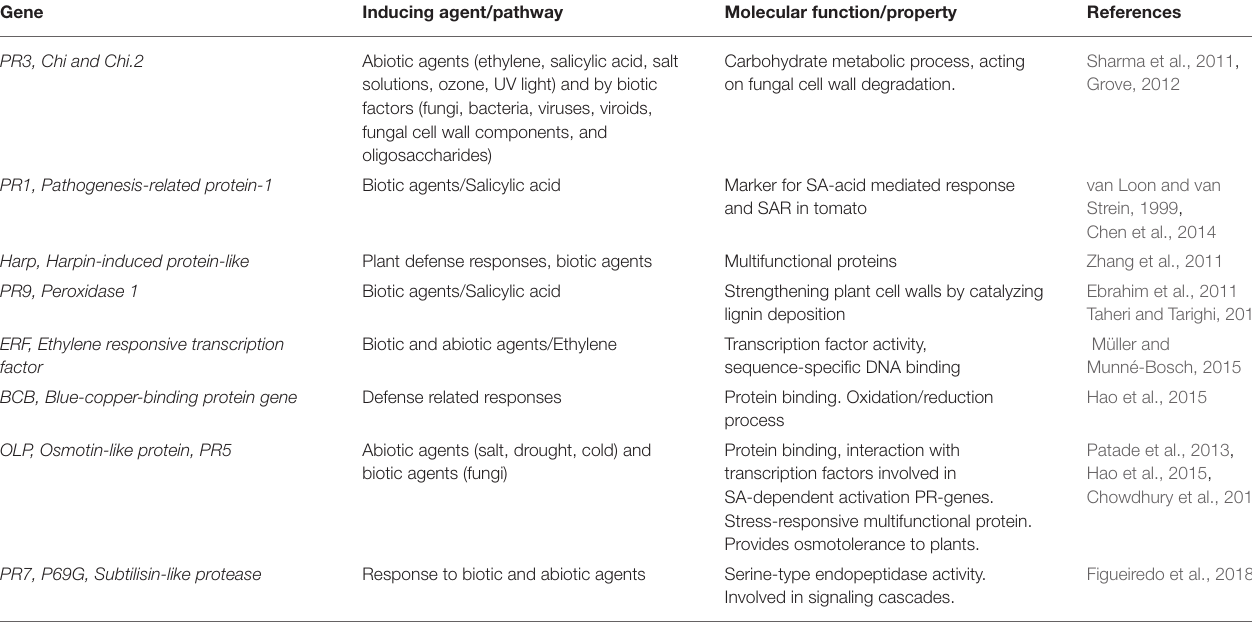
TABLE 1 | Associated functions to overexpressed defense related genes, according to RT-qPCR, in tomato plants in response to BP178